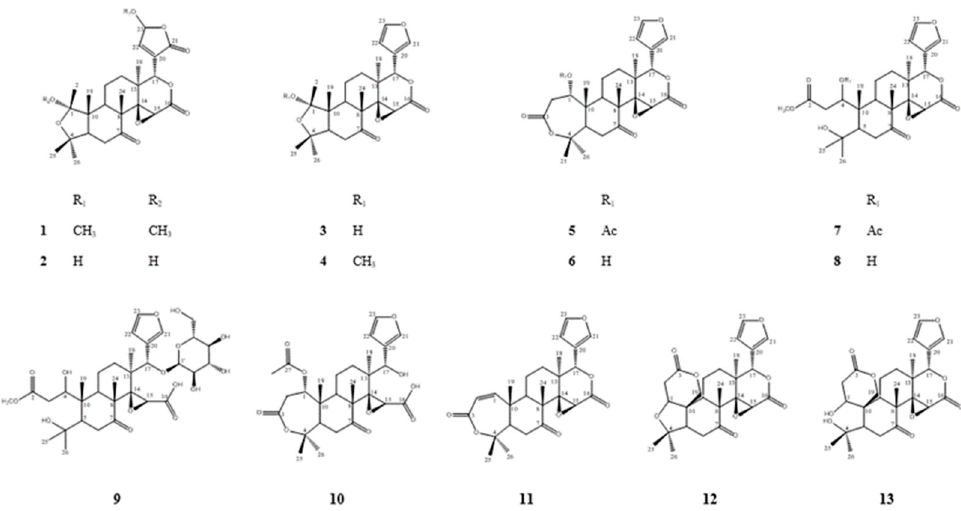
Figure3. Structuresofthelimonoidsisolatedfrom C.junos seeds. MethylsudachinoidA( 1 ),